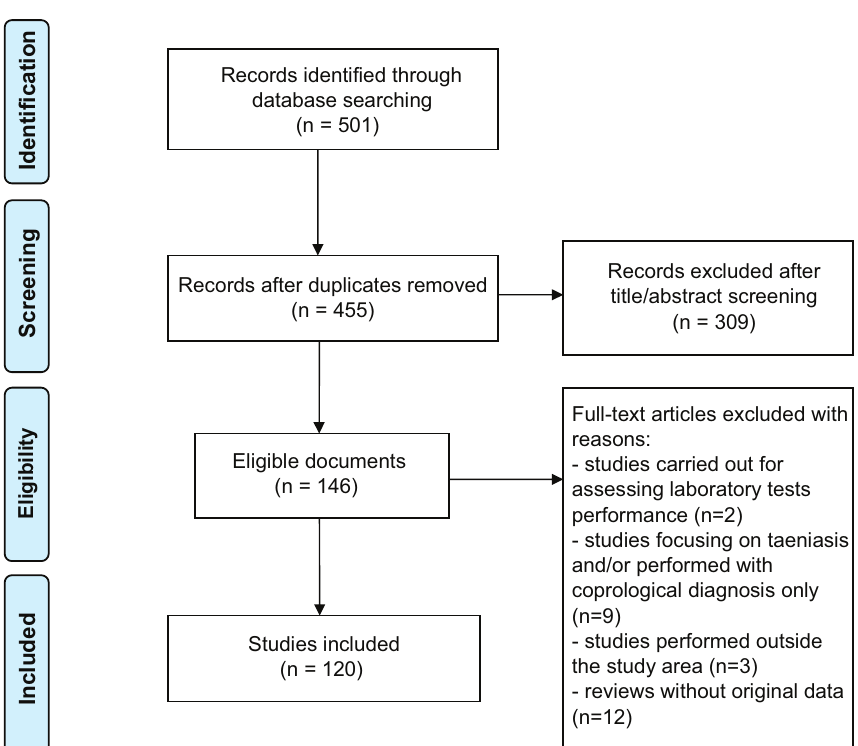
Figure 1. Workflow followed to identify articles in